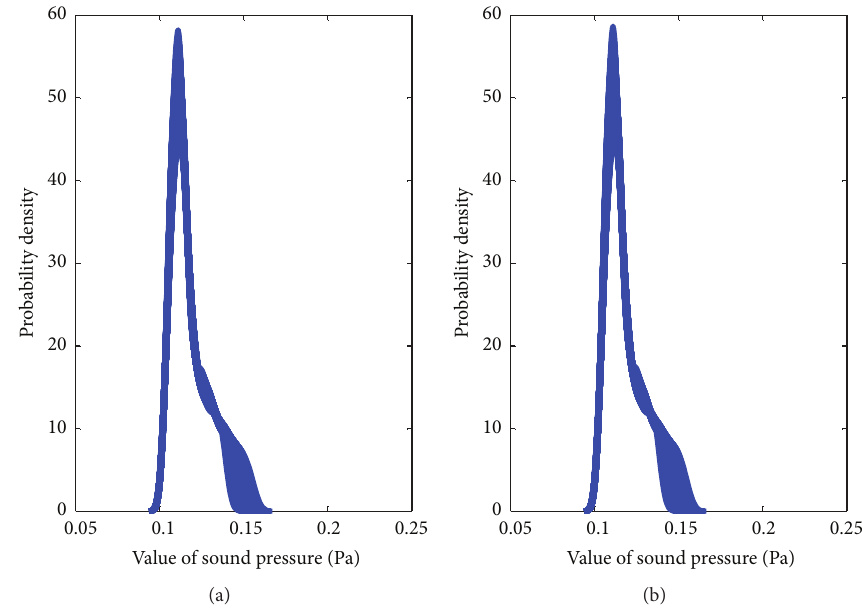
Figure 16: The lower and upper bounds of the response probability density of node 𝑅2 calculated by (a) MCS and (b)